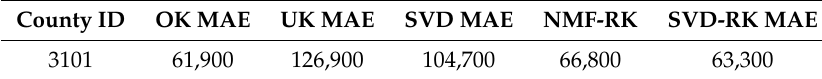
Table 6. Removing Outliers for County Id 3101.